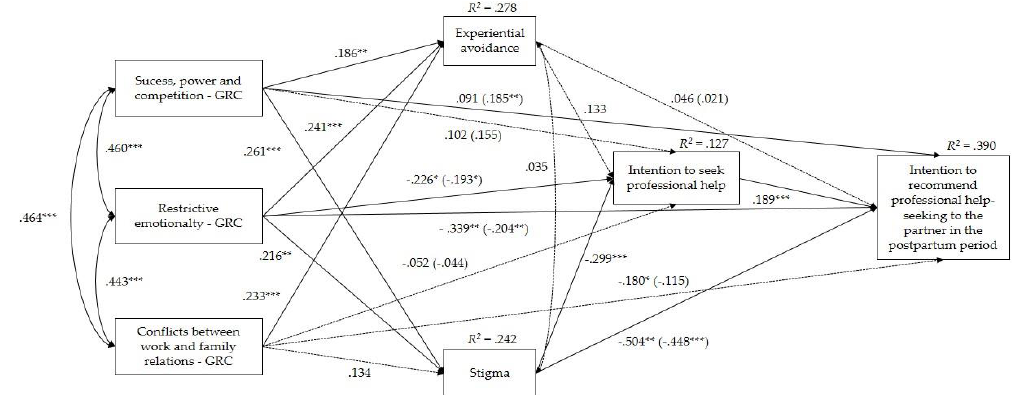
Figure 2. Mediation model with determinants of the intention to recommend professional help-seeking to a partner with mood and anxiety disorders in the postpartum period. The values represented in the lines correspond to standardized values. Those out of parentheses present the total e ff ects, and those in parentheses, the direct e ff ects, after the introduction of the mediating variables in the model. There was a significant positive association between experiential avoidance and type of recruitment ( B = 0.188, SE = 0.212, p = 0.007). The remaining associations with covariates were not